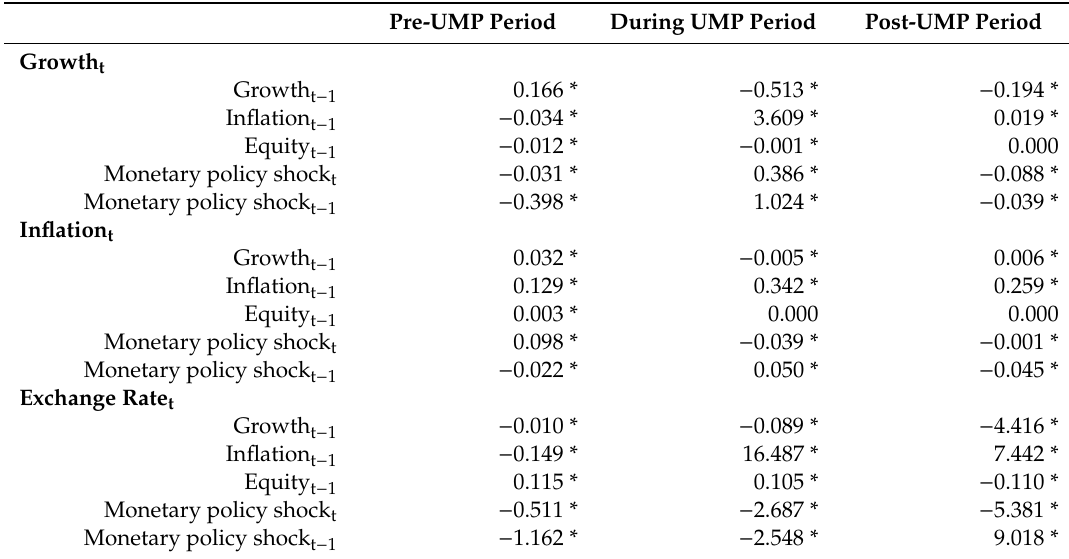
Table 5. Panel VARX estimations for exchange rates.